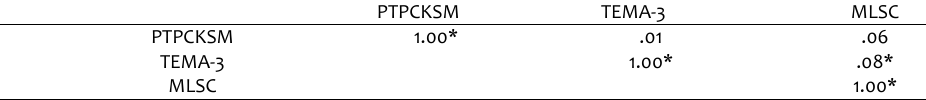
Table 8. Relation between teachers’ pedagogical content knowledge and children’s mathematics ability and mathematics liking